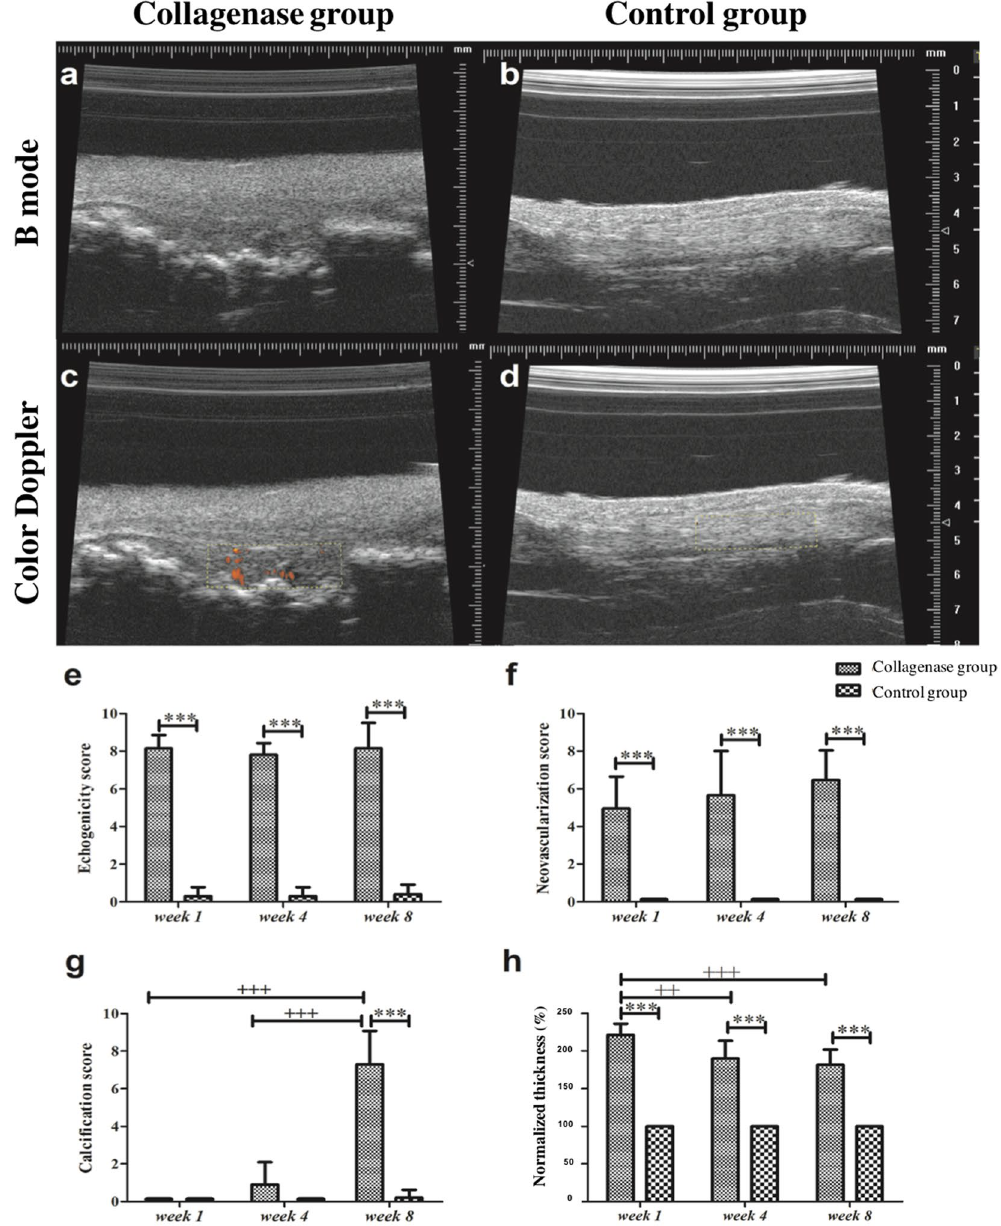
Figure 2. The ultrasound images and ultrasound features scores. At week 8 , the collagenase group showed increased tendon thickness, diffuse hypoechoic changes, multiple calcification ( a ), and abundant neovascularization ( c ). In the Control group, such ultrasound features were seldom visible ( b and d ). The summary scores of US features, including echogenicity ( e ), neovascularization ( f ), calcification ( g ), and normalized thickness ( h ). * Compared with the control group; + compared within the collagenase group; * / + p < 0.05; ** / ++ p < 0.01; *** / +++ p <